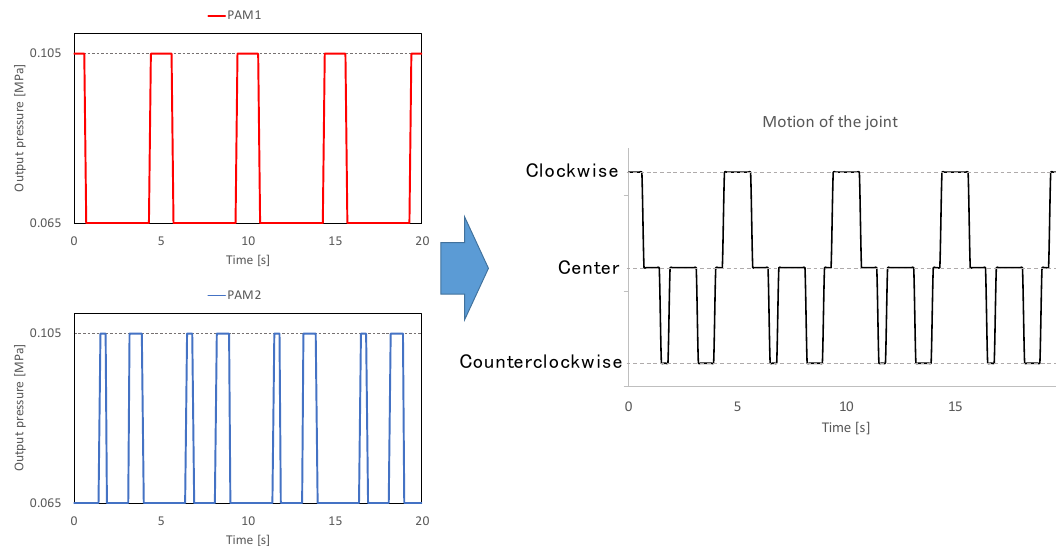
Figure 7. Examples of rectangular wave signals ( ω 1 = 0.4 Hz, φ 1 = π/2, ω 2 = 0.2 Hz, φ 2 = 23π/16) ( left ) and motion of the joint ( right ).